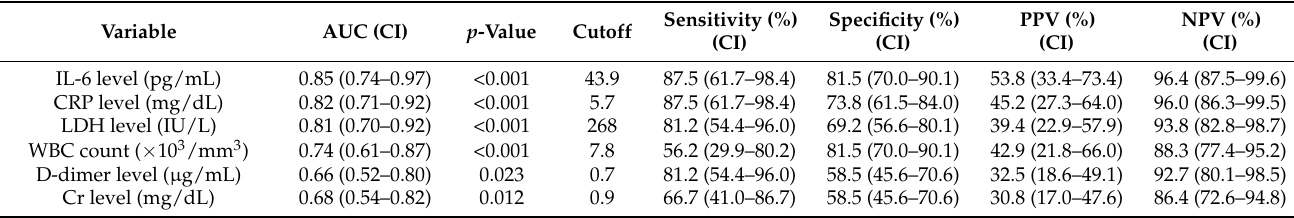
Table 3. Diagnostic characteristics of each marker to predict respiratory failure within three days from the measurement of these marker